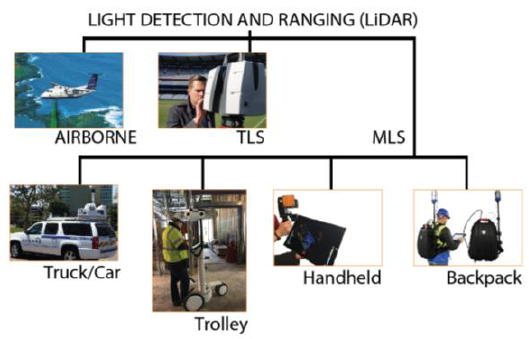
Figure 2. LiDAR types for data acquisition.